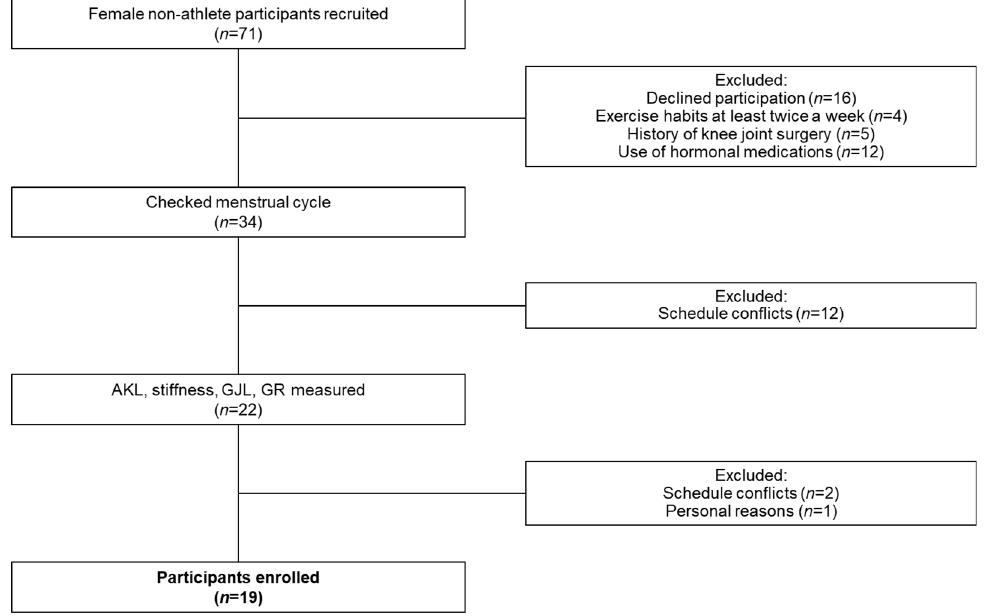
Figure 1. Flowchart for selection of female non-athlete participants. AKL, anterior knee laxity; GJL, general joint laxity; GR, genu recurvatum.